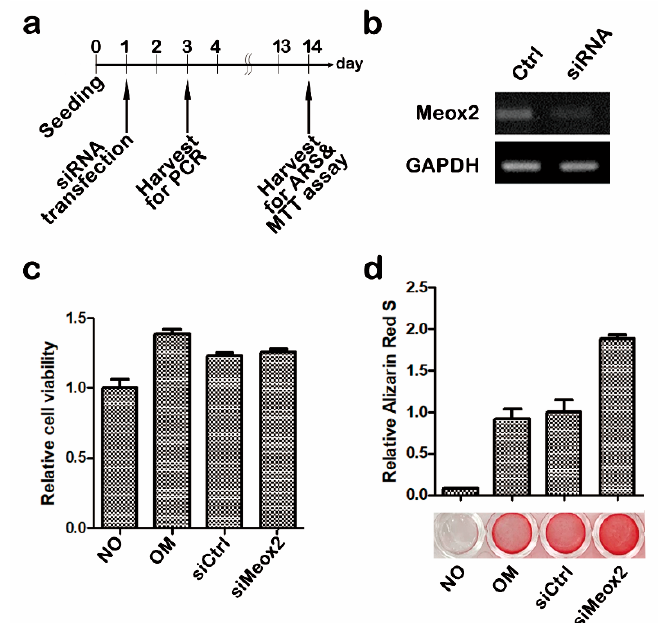
Figure 1. Effect of Meox2 on the viability of human periodontal ligament fibroblasts (hPDLF) ( a – d ). Showing of schematic diagram of in vitro cell cultivation schedule ( a ). The relative expression of si Meox2 was analyzed using qRT-PCR ( b ). Cell viability of hPDLFs were analyzed MTT assay. hPDLFs were treated with siRNA against Meox2 (10 nM) for 48 h ( c ). Alizarin red S staining of hPDLFs under 48 h of osteogenic culture with si Meox2 ( d ). Alizarin red S staining was quantified by cetylpyridinium chloride extraction and measuring the absorbance at 562 nm.